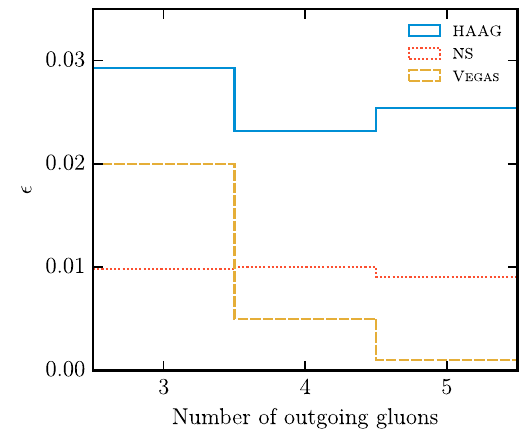
Fig. 6 Visualisation of the efficiencies listed in Table 5